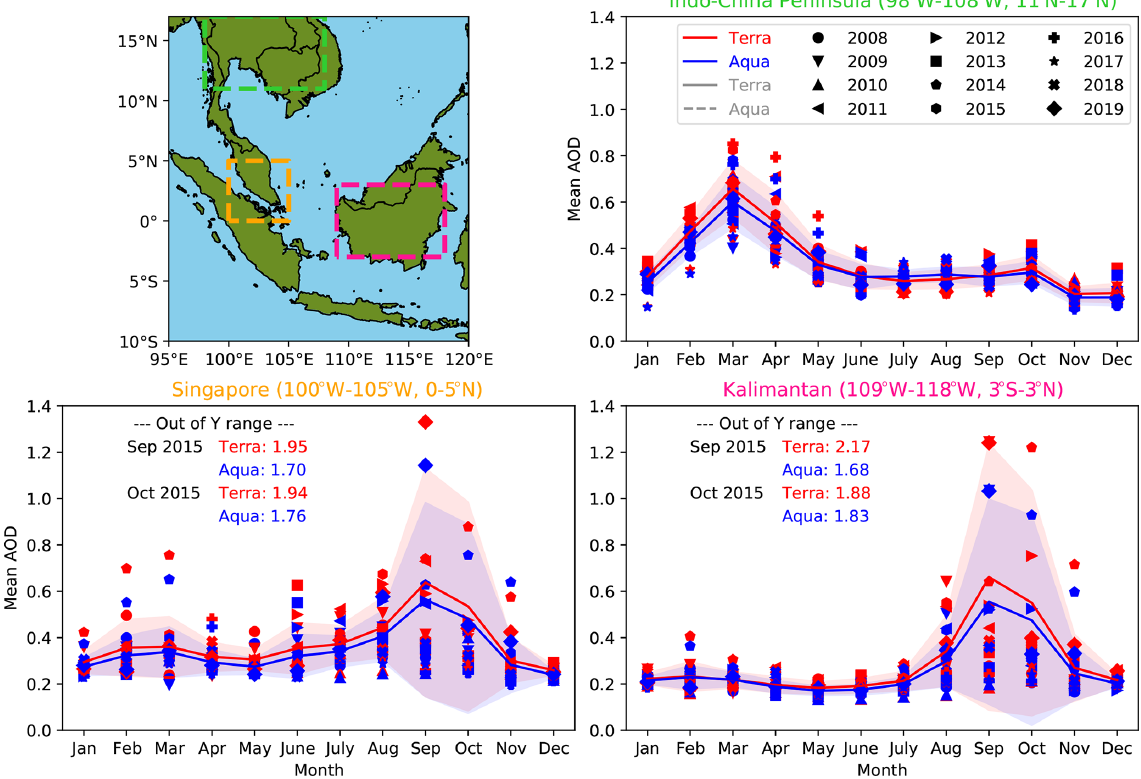
Figure 2. MODIS-observed monthly mean AOD averaged over 2008–2019, separately for the three areas shown on the upper left map. The data MOD/MYD08_M3 is 1 ◦ × 1 ◦ . The shading shows ± SD. The rain belt shifts between ∼ 20 ◦ N (boreal summer) and ∼ 5 ◦ S (boreal winter) around this area (e.g., Schneider et al.,